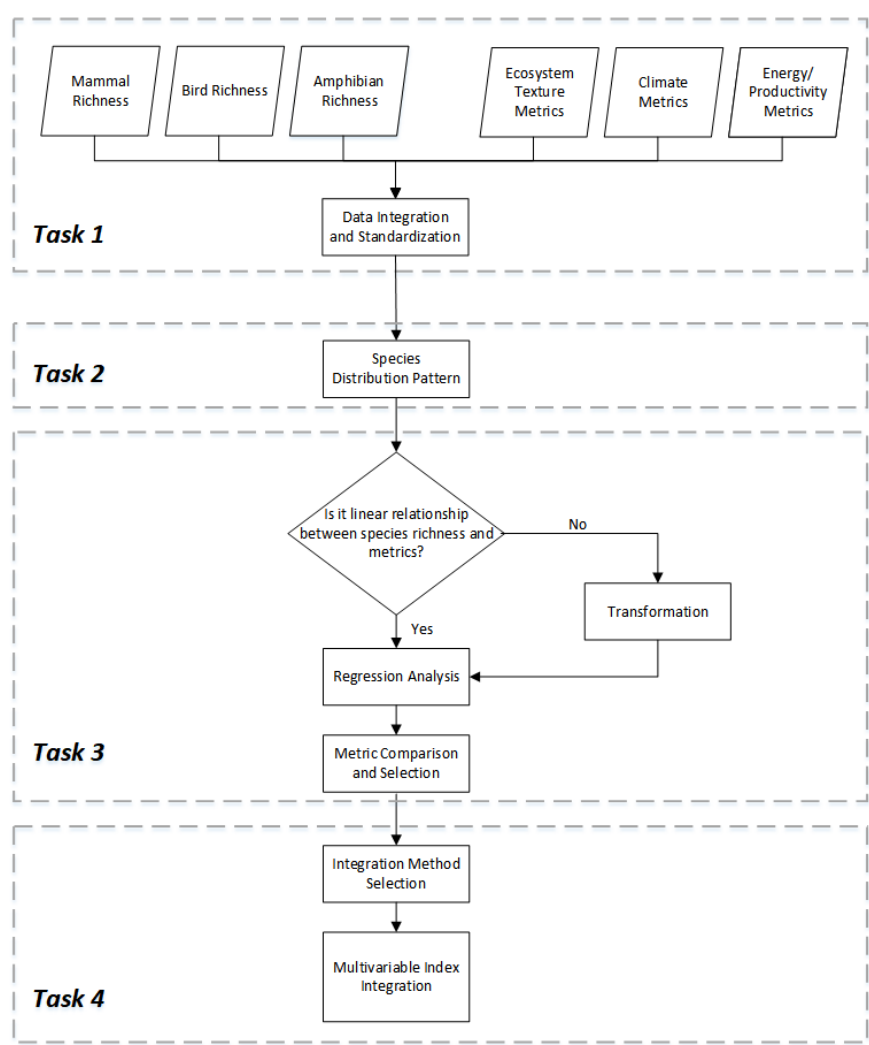
Figure 1. Flowchart of the comparison of the remote sensing metrics and development of a multivariate integration index.